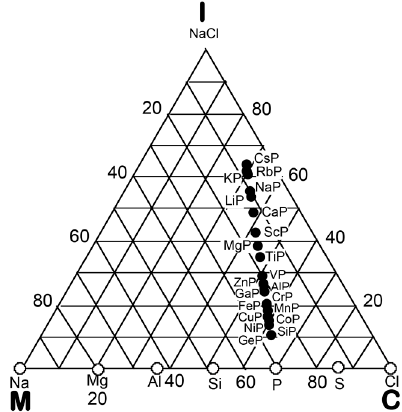
(Table 2) into Equations (17) and (18) for equiatomic MP compounds (solid circles) and seven elements (open circles) in period 3 of the Periodic Table.